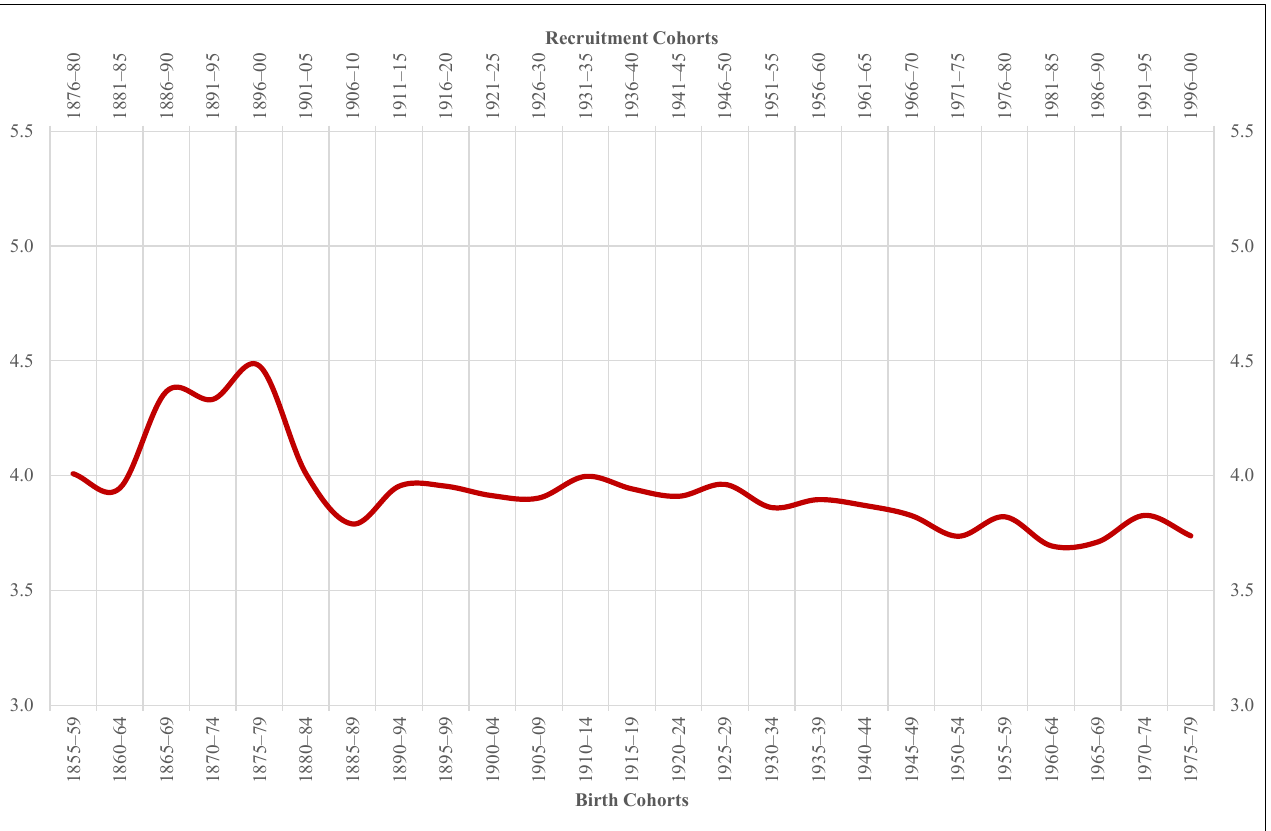
Figure 4. Variation coefficients of the height sample Extremadura (%).